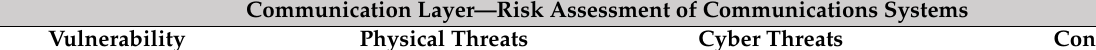
Table 10. Risk assessment for communication